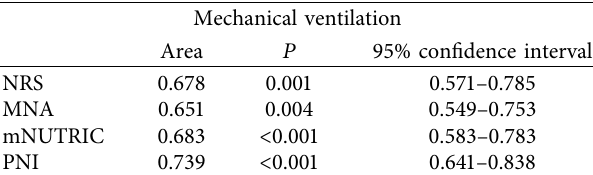
Table 7: ROC curves in predicting mechanical ventilation in nutrition tools.